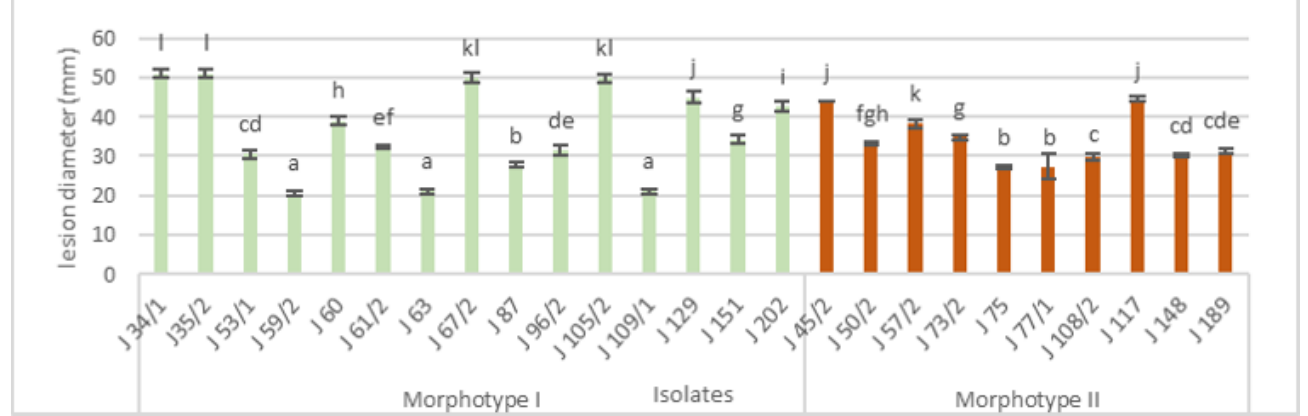
Figure 1. Pathogenicity of identified Neofabraea isolates ex situ on inoculated apple fruit after 28 days of incubation at room temperature. The same letters represent no significant differences according to Duncan’s test ( p < 0.05).